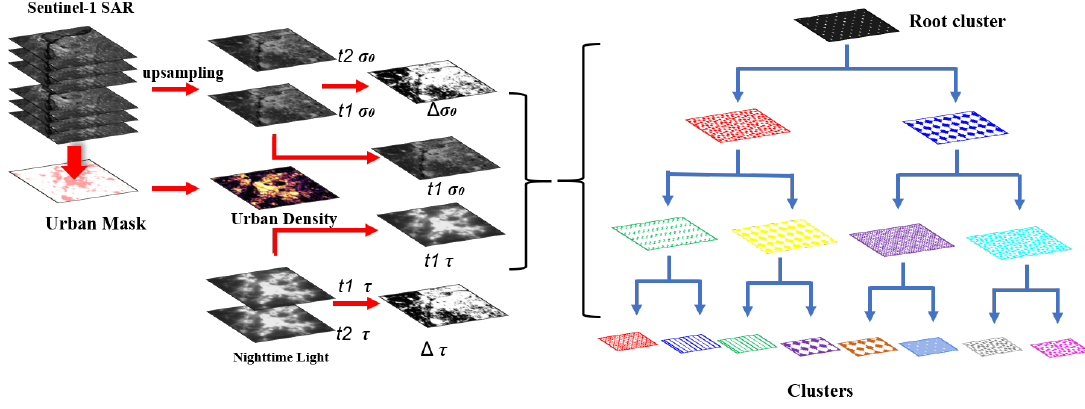
Figure 1. Workflow of the urban change pattern exploration procedure used in this chapter.